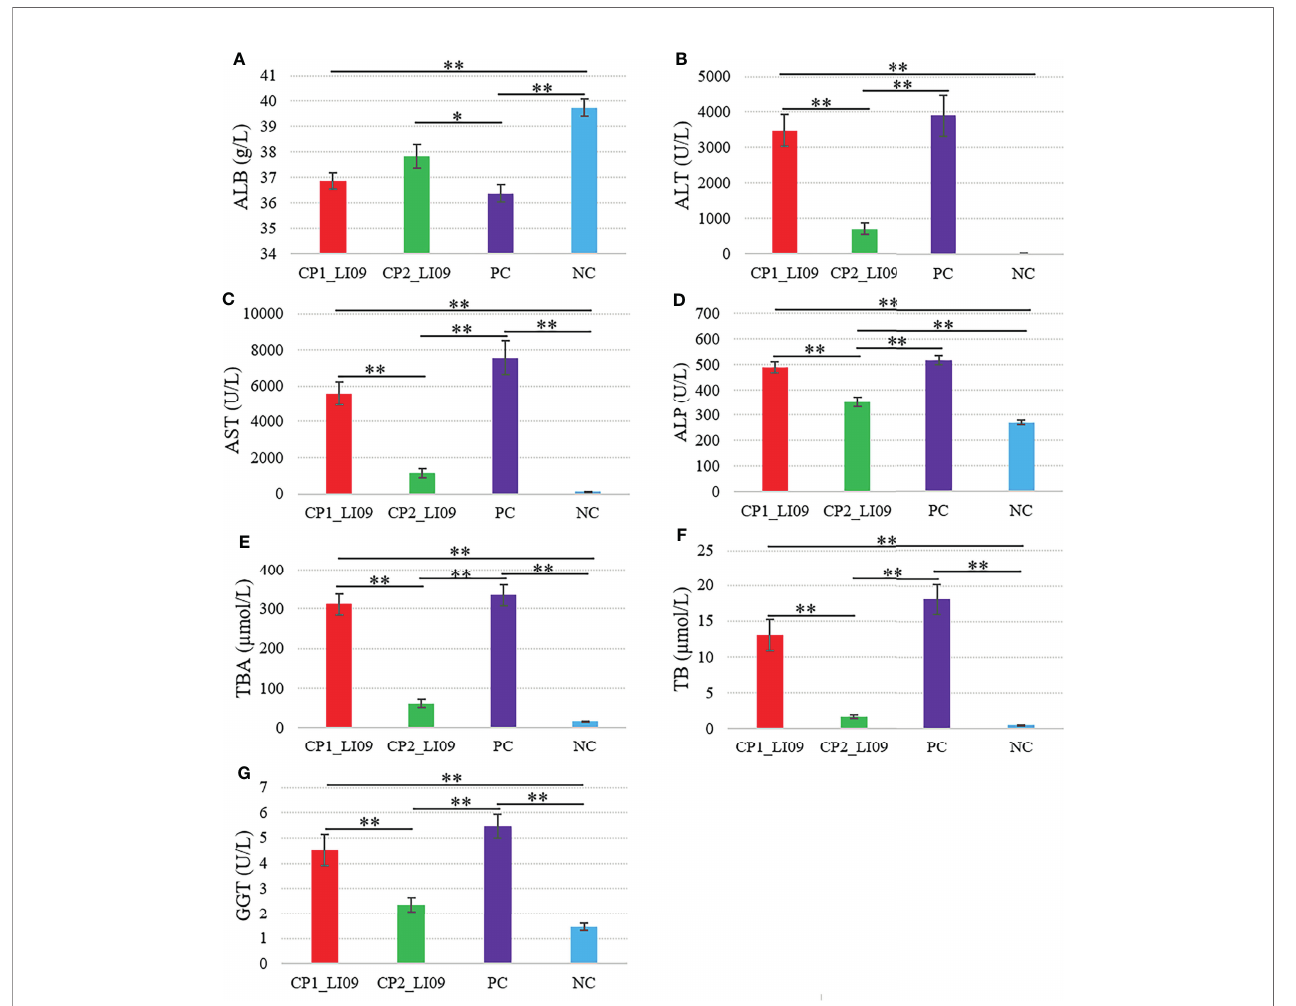
FIGURE 2 | Comparisons of liver function variables in the LI09 cohorts with different cytokine pro fi les (i.e., CP1_LI09 and CP2_LI09 cohorts) and control cohorts. PC represents positive control; NC represents negative control. (A) ALB; (B) ALT; (C) AST; (D) ALP; (E) TBA; (F) TB; (G) GGT. * represented 0.01 < P < 0.05; ** represented P <